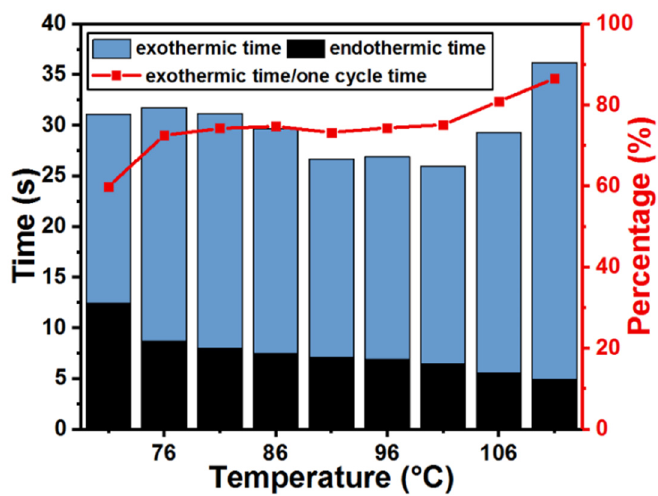
Figure 8. Tested endothermic and exothermic periods versus heating temperature.